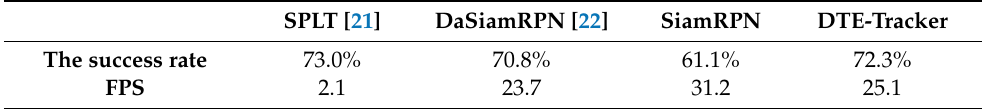
Table 3. Comparison between this method and mainstream